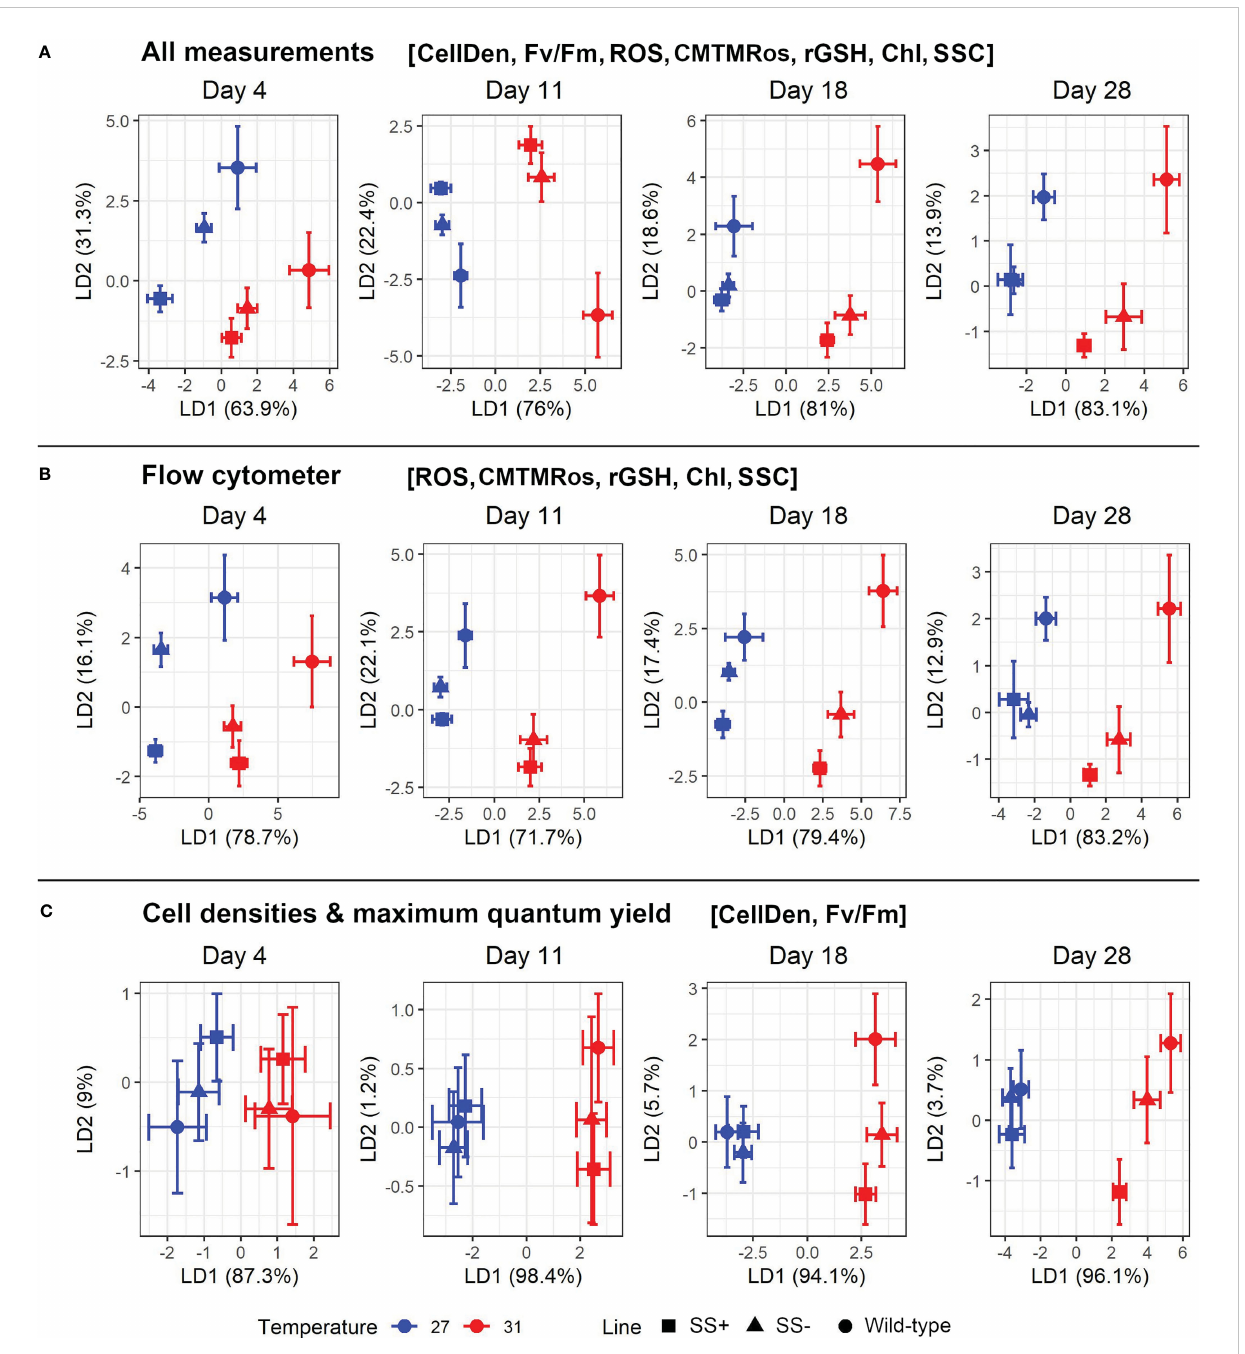
FIGURE 5 Plot of the two major linear discriminant functions for each strain type and temperature using various combinations of variables. (A) uses all seven retained variables (i.e., excluding f PSII and FSC), (B) just uses the fi ve retained cytometry-based variables (i.e., ROS), CMTMRos, rGSH, Chl and SSC) and (C) just uses the two non- fl ow cytometry variables retained (i.e., CellDen and F v /F m ). Mean values with their 95% con fi dence limits are given for the strain group (WT, SS+,